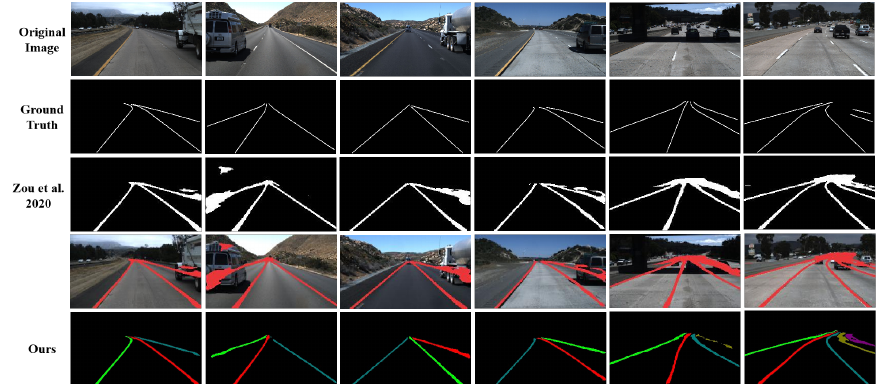
Figure 7. Visual comparison with the best method [28] in the Tusimple benchmark under occlu- sion